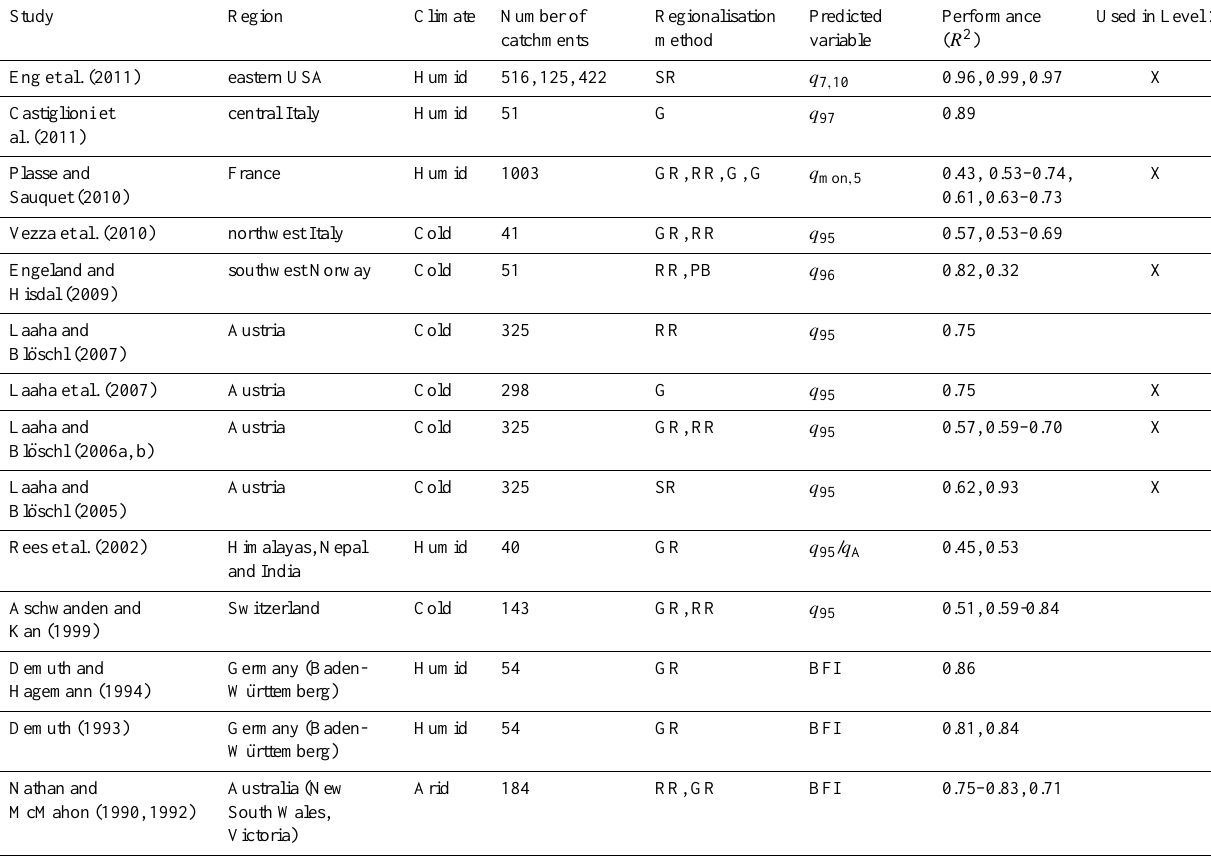
Table 1. Summary assessment of studies for low flow estimation in ungauged catchments used in Level 1 assessment. Performance indicates the leave-one-out assessment of model efficiency in terms of the coefficient of determination R 2 . Low flow regionalisation methods include: process based (PB), global regression (GR), regional regression (RR), geostatistics (G) and short records (SR). Predicted variable indicates the low flow index estimated in the study and includes: 7days 10yr specific runoff ( q 7 , 10 ) , monthly 5day minimum specific runoff ( q mon , 5 )